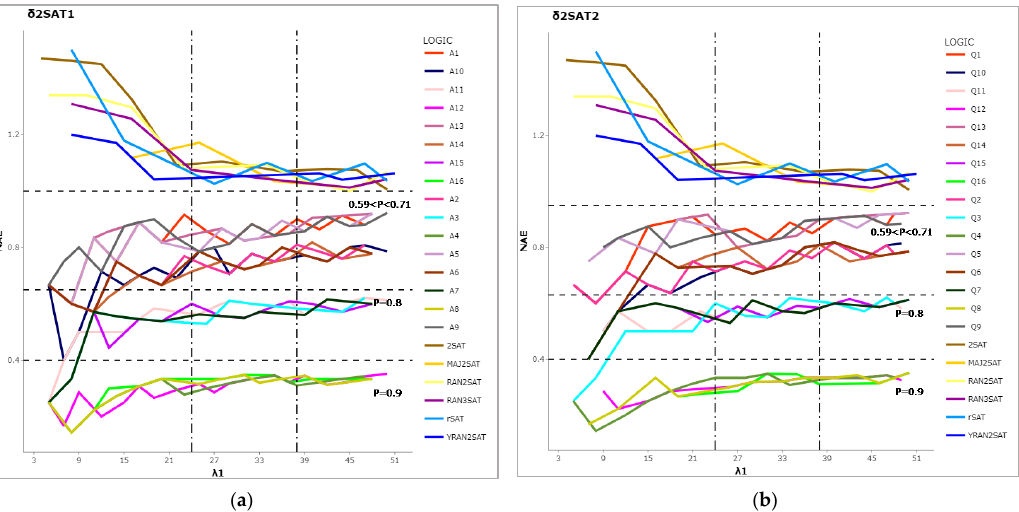
Figure 5. NAE line representation for models in both types of logic ( a ) 1 2 SAT 